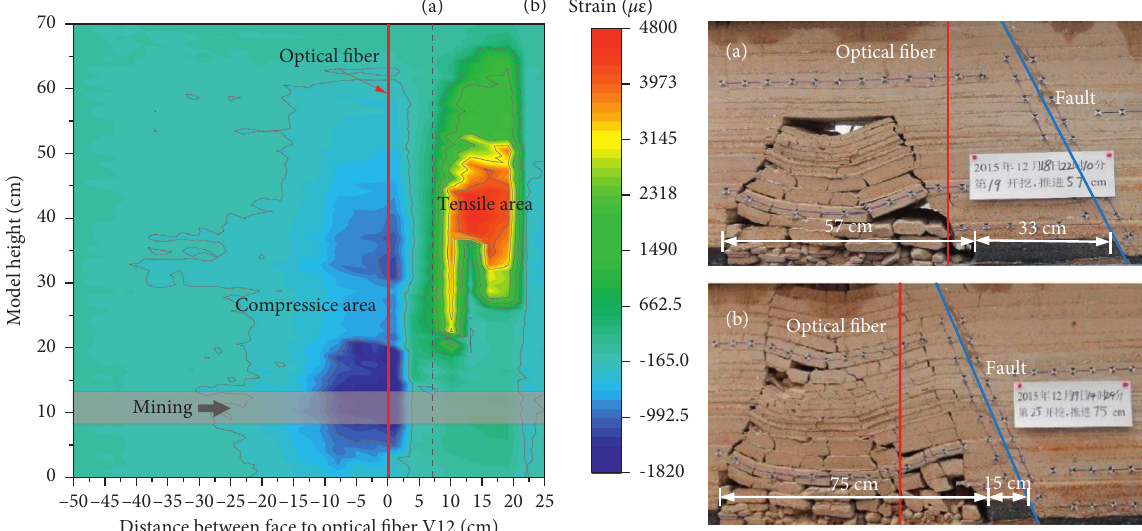
Figure 7: Fault strain evolution in the lower disk of the fault mining.